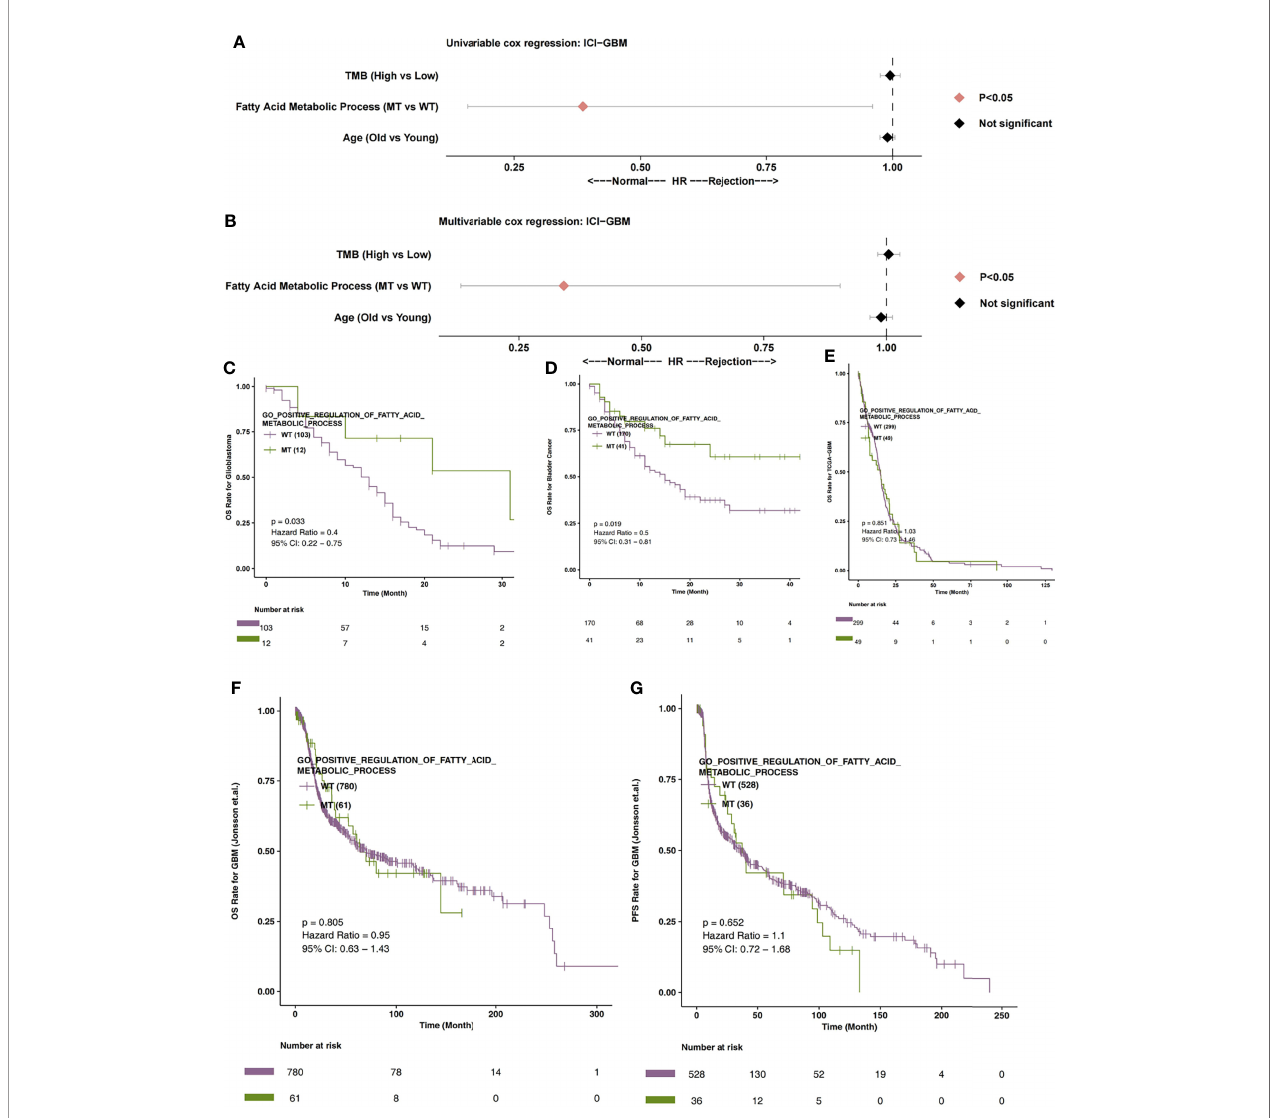
FIGURE 2 | (A) The univariable Cox regression analysis model of ICI-GBM. (B) The multivariable Cox regression analysis model of ICI-GBM. (C) The Kaplan Meier curve of the fatty acid metabolic processes of the MT and WT groups in the ICI-GBM queues. (D) The Kaplan Meier curve of the fatty acid metabolic processes of the MT and WT groups in the ICI-BLCA queues. (E) The Kaplan Meier curve of the fatty acid metabolic processes of the MT and WT groups in the TCGA-GBM queues. (F) The Kaplan Meier curve of the fatty acid metabolic processes of the MT and WT groups in the Jonsson-GBM queues in relation to OS. (G) The Kaplan Meier curve of the fatty acid metabolic processes of the MT and WT groups in the Jonsson-GBM queues in relation to PFS. MT, mutant-type; WT, wild-type; OS, Overall Survival; PFS, Progression-free